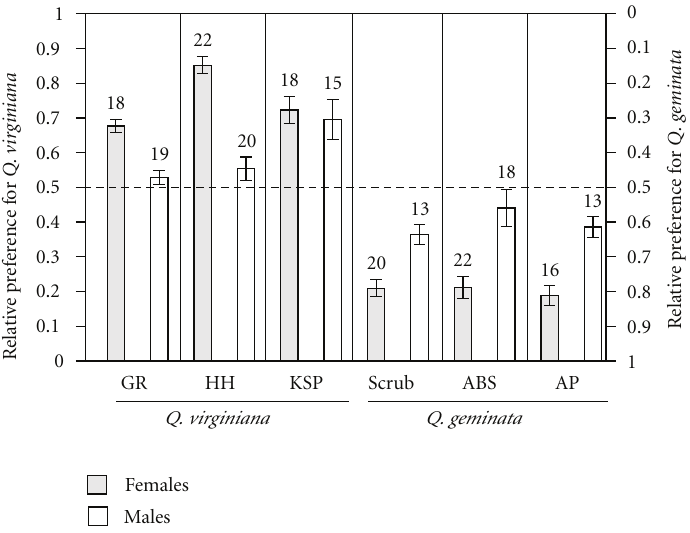
Figure 1: Host preference of individual B. treatae gall wasps expressed for each of three Q. virginiana and three Q. geminata host-associated populations during choice tests that paired each wasp’s native/natal host with the alternative oak species. Illustrated is the mean ( ± SE) of the proportion of time spent on the native host plant by each sex within each population. The dashed line highlights no preference (defined as 50% of time spent on each host). Note each population di ff ered significantly from 50% ( P < 0 . 0001). Numbers above the SEs are the number of replicates. Note the reversed left and right y -axis.